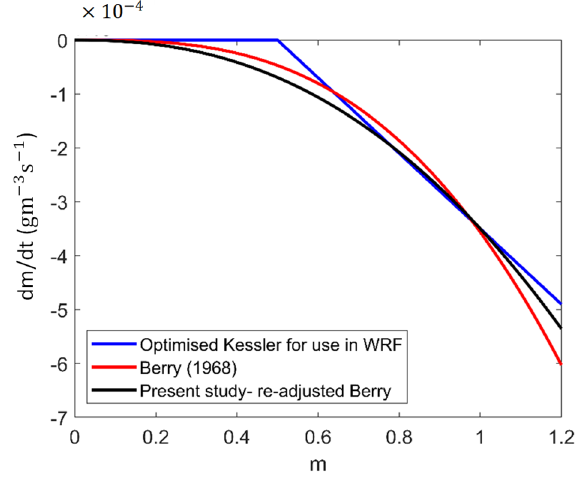
Figure 7. Optimising the Kessler scheme with the Berry scheme. Auto-conversion rate (k 1 ) and cloud threshold (a) obtained from the best fit of the standard Kessler (blue line plot) and Berry schemes (red line plot): k 1 ~ 7 × 10 − 4 s − 1 and a = 0.5 gm − 3 . Modified auto-conversion rate (k (cid:48)(cid:48) ) obtained from the best fit of the new auto-conversion correlation with the Berry schemes: k (cid:2869)(cid:4593)(cid:4593) = 3.5 × 10 (cid:2879)(cid:2872) (gm (cid:2879)(cid:2871) ) (cid:2879)(cid:2869) s (cid:2879)(cid:2869) . Cloud parameters for this case study: N ~ 124 cm − 3 , D b ~